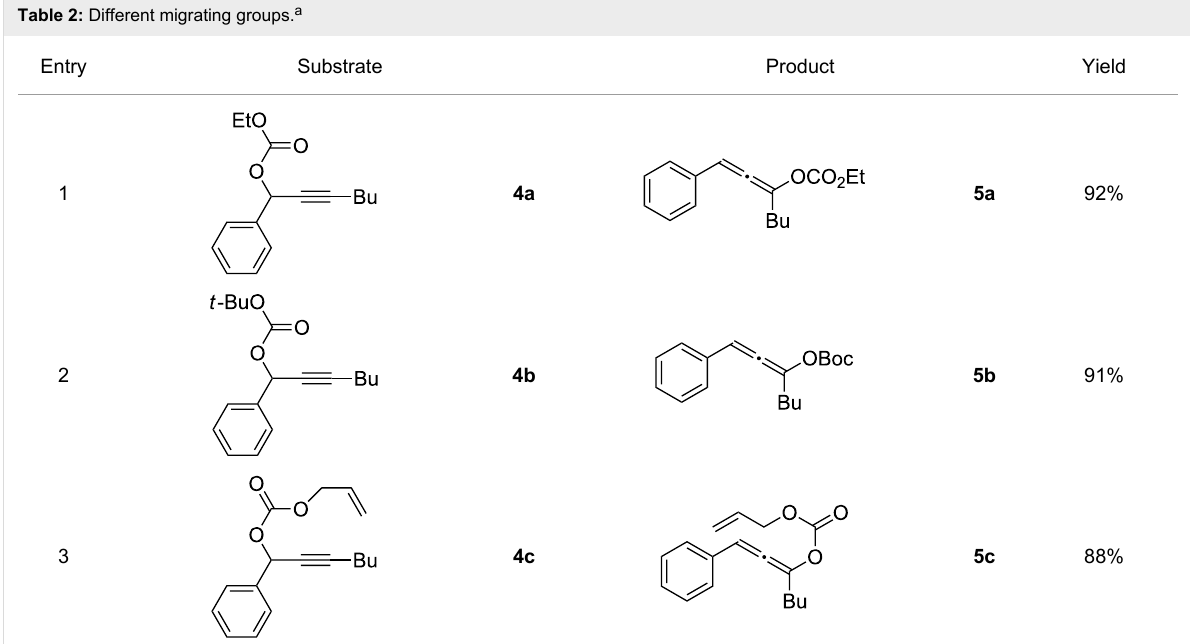
Substrates that did not form the desired allenes b